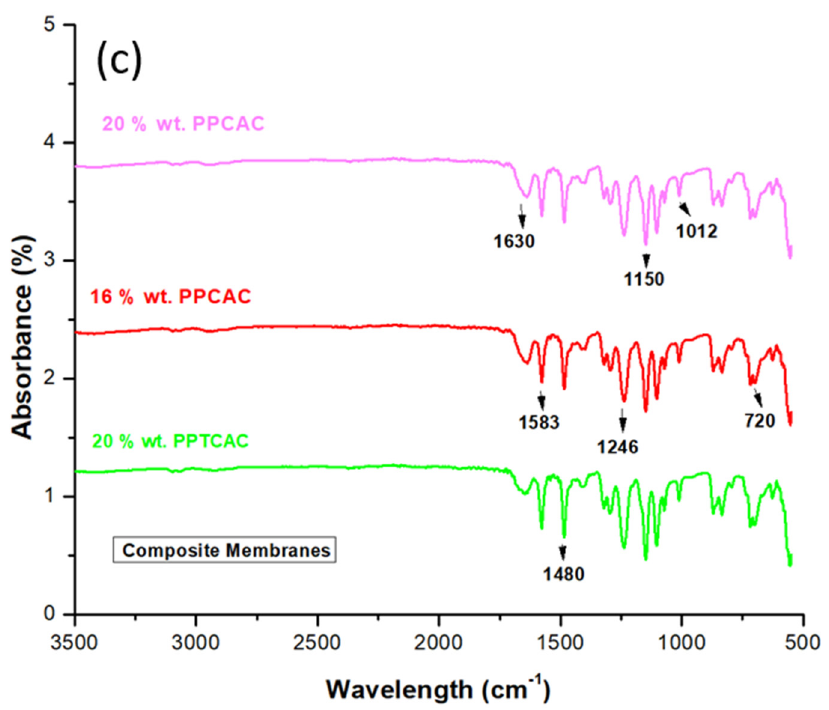
Figure 2. ATR-FTIR spectra for ( a ) 16% wt. PES membranes, ( b ) 20% wt. PES membranes and ( c ) composite membranes.